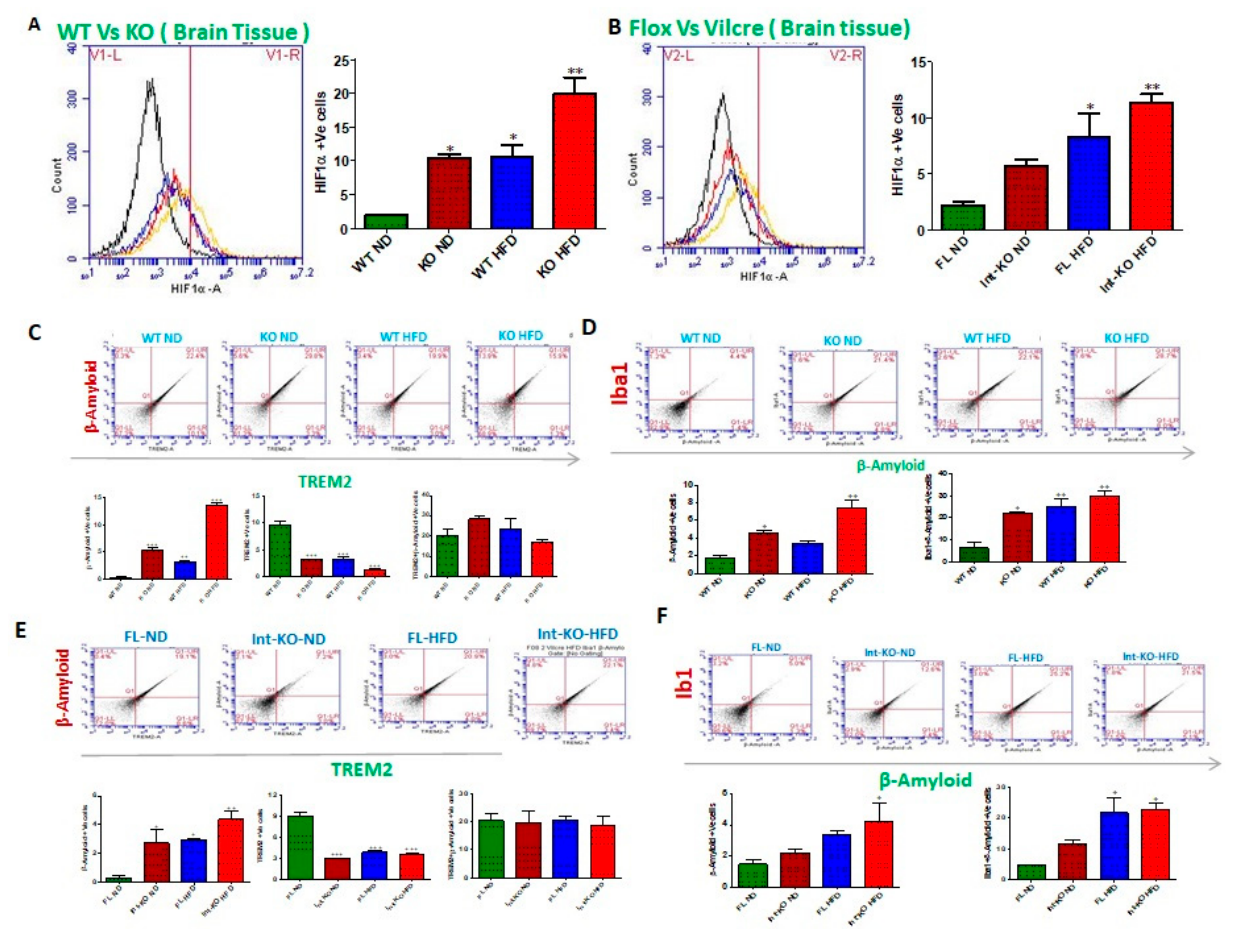
Figure 7. Intestinal epithelial deficiency of Jak3 causes Brain-hypoxia led increase in microglial accumulation of Abeta in the brain. ( A , B ), Representative flow cytometric histogram graphs of individual mouse brain cells showing the levels of expression of hypoxia inducible factor 1- α (HIF1- α ) in the four indicated groups of global Jak3 deficiency ( A ) and IEC Jak3 deficiency ( B ), respectively ( n = 5/group), are shown in the left panel, and the corresponding histogram bar graphs indicating mean ± SD values in the right panels are shown for the comparative average cell counts for the indicated groups of mice. *, **, *** Indicate statistically significant difference from the corresponding controls (A: KO-ND#1 p = 0.06, WT-HFD#2 p = 0.05 KO-HFD#3 p = 0.04; B: Int-KO-ND#1 p = 0.06, plots to determine the impact of global Jak3 deficiency on microglial accumulation of Abeta in the individual mouse brain tissues from “A” by determining the double positive cells (Quadrant:UR) for microglial Abeta receptor TREM-2 on the X axis and Abeta on the Y axis ( C ) and microglial marker Iba1 on the X axis and Abeta on the Y axis ( D ) under ND or HFD. The lower panels in “C” and “D” show the corresponding bar chart results following repeating ( n = 5) the FACS experiments, and mean ± SD values are shown as bar graph for the comparative average cell counts for the indicated groups of mice. *, **, *** denote p < 0.04 in all groups. ( E , F ), similar strategies as in C-D were used to perform FACS analysis to determine the impact of intestinal epithelial Jak3 deficiency on microglial accumulation of Abeta in the individual mouse brain tissues from “B” in the indicated four groups under ND or HFD. *, **, *** denote statistically significant values in the indicated group assumed at p <